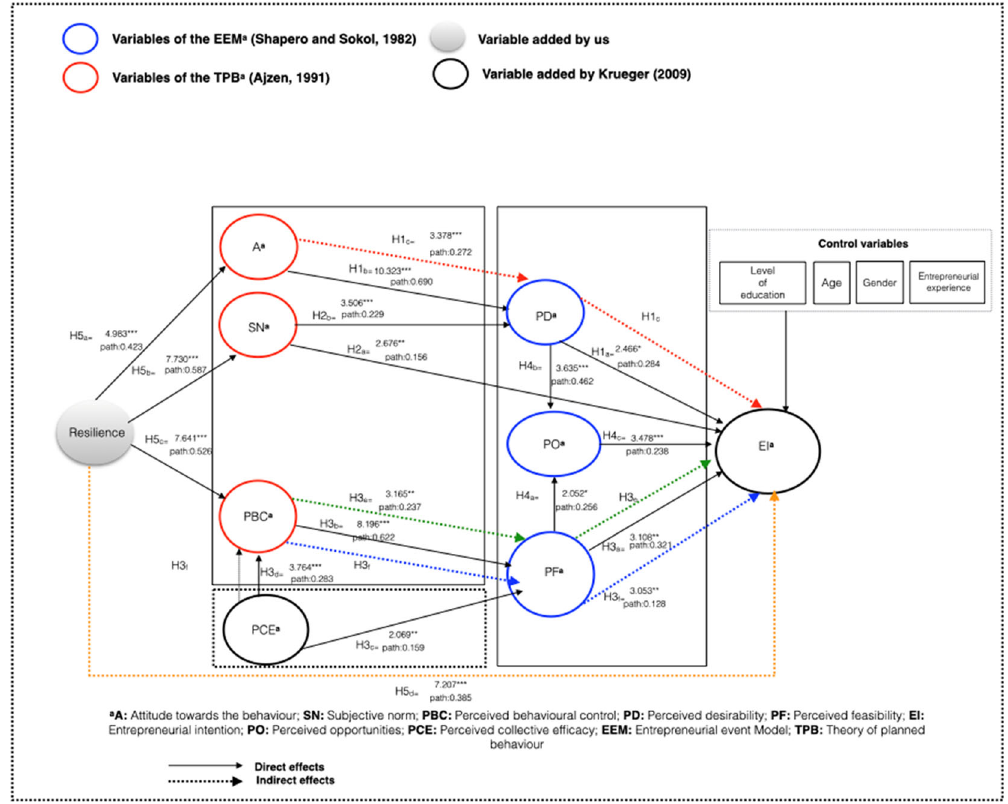
Figure 3. Final Structural model results. This figure shows the results obtained in each of the hypotheses raised. Resilience does have a direct and significant influence on attitude, subjective_norm, and